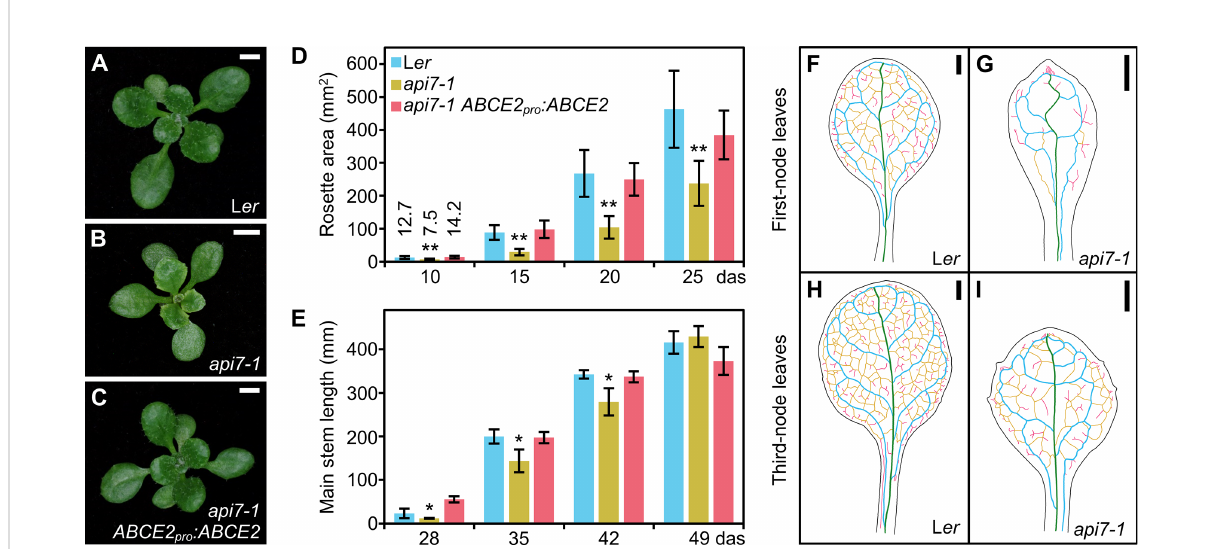
FIGURE 1 Morphological phenotype of the api7-1 mutant. (A – C) Rosettes from (A) the wild-type L er , (B) the api7-1 mutant, and (C) an api7-1 ABCE2 pro : ABCE2 mutant and transgenic plant. Pictures were taken 16 das. Scale bars indicate 2 mm. (D, E) Growth progression of (D) rosette area and (E) main stem length. (D) Bars indicate mean and (E) median values. Error bars represent (D) standard deviation and (E) median absolute deviation. Asterisks indicate a signi fi cant difference with L er in (D) a Student ’ s t test (10 < n < 17) or (E) a Mann-Whitney U test ( n = 8) (* P < 0.05, ** P < 0.001). (F – I) Venation pattern of api7-1 fi rst- and third-node leaves. Representative diagrams of mature (F, G) fi rst- and (H, I) third-node leaves from (F, H) L er and (G, I) api7-1 plants after visualization of 12 samples per organ and genotype. Margins were drawn in black, primary veins in green, secondary veins in blue, higher-order connected veins in yellow, and higher-order disconnected veins in pink. Organs were collected 21 das. Scale bars indicate 1